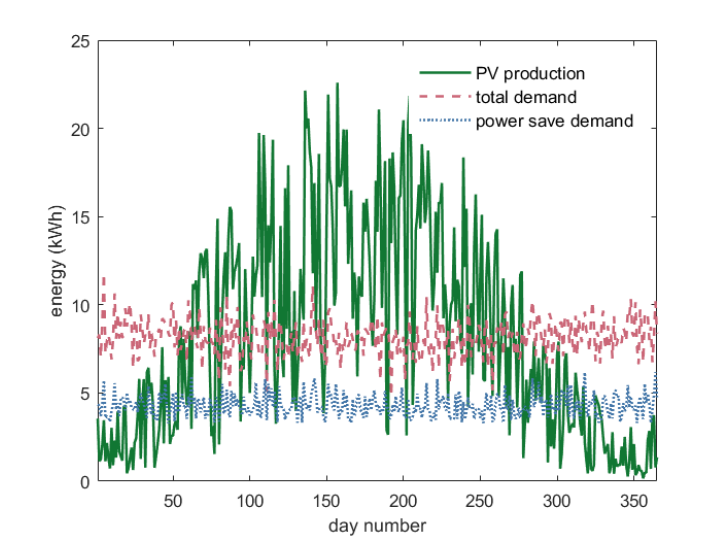
Figure 2. The energy production (green) and demand (red) for each day in the year, in kWh. The demand in power-save mode is shown in